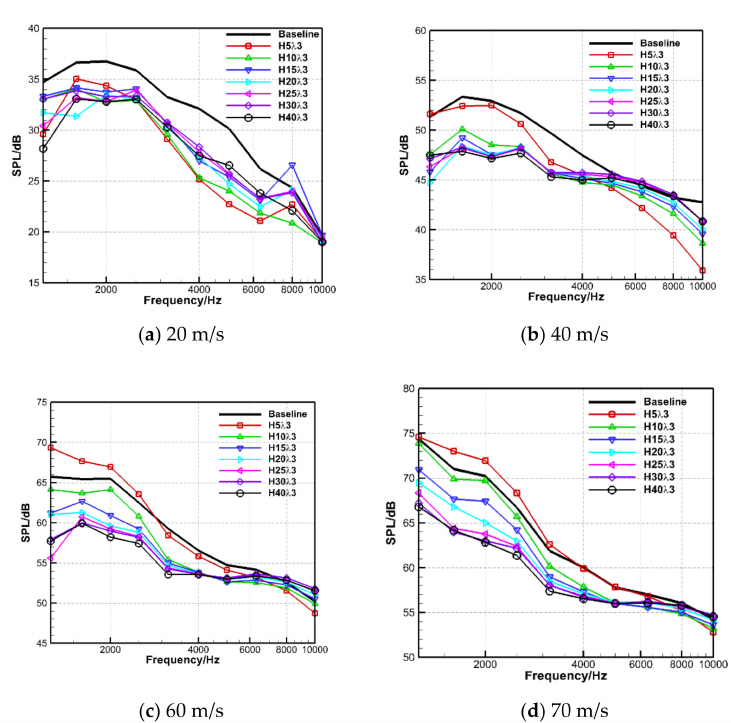
Figure 13. Spectra of the TE noise with different sawtooth amplitudes ( λ = 3